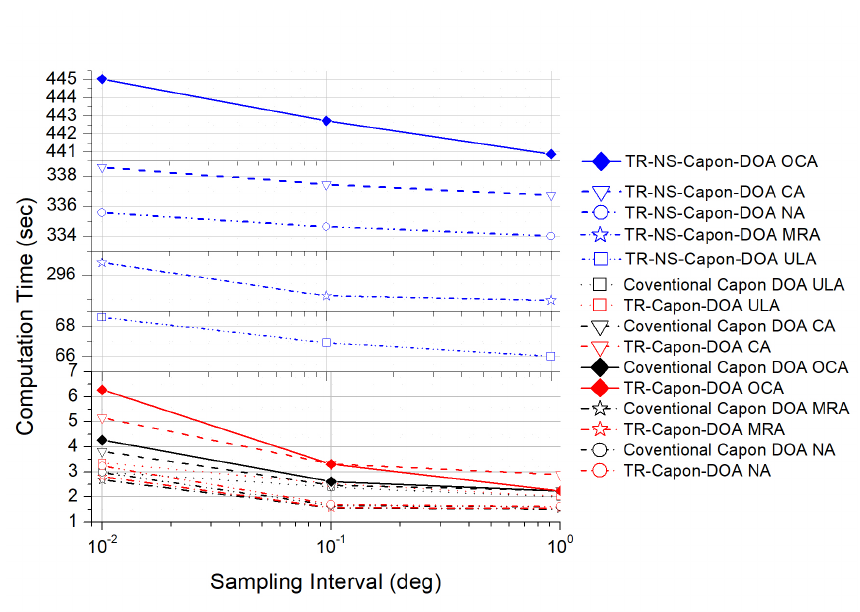
Figure 18. Computation time comparison with different sampling